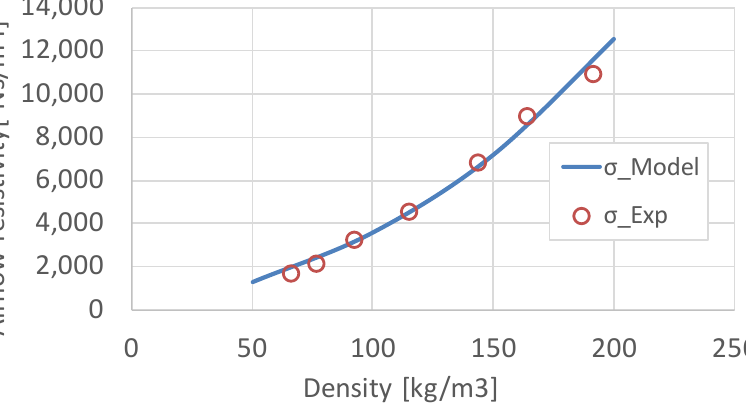
Figure 6. Comparison between the experimental airflow resistivity values and analytical model (10) with a = 40.1 µm.